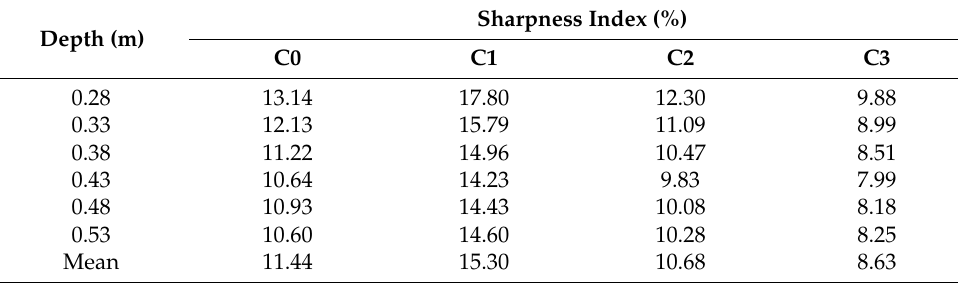
Table 4. Sharpness index between different datasets at different depth